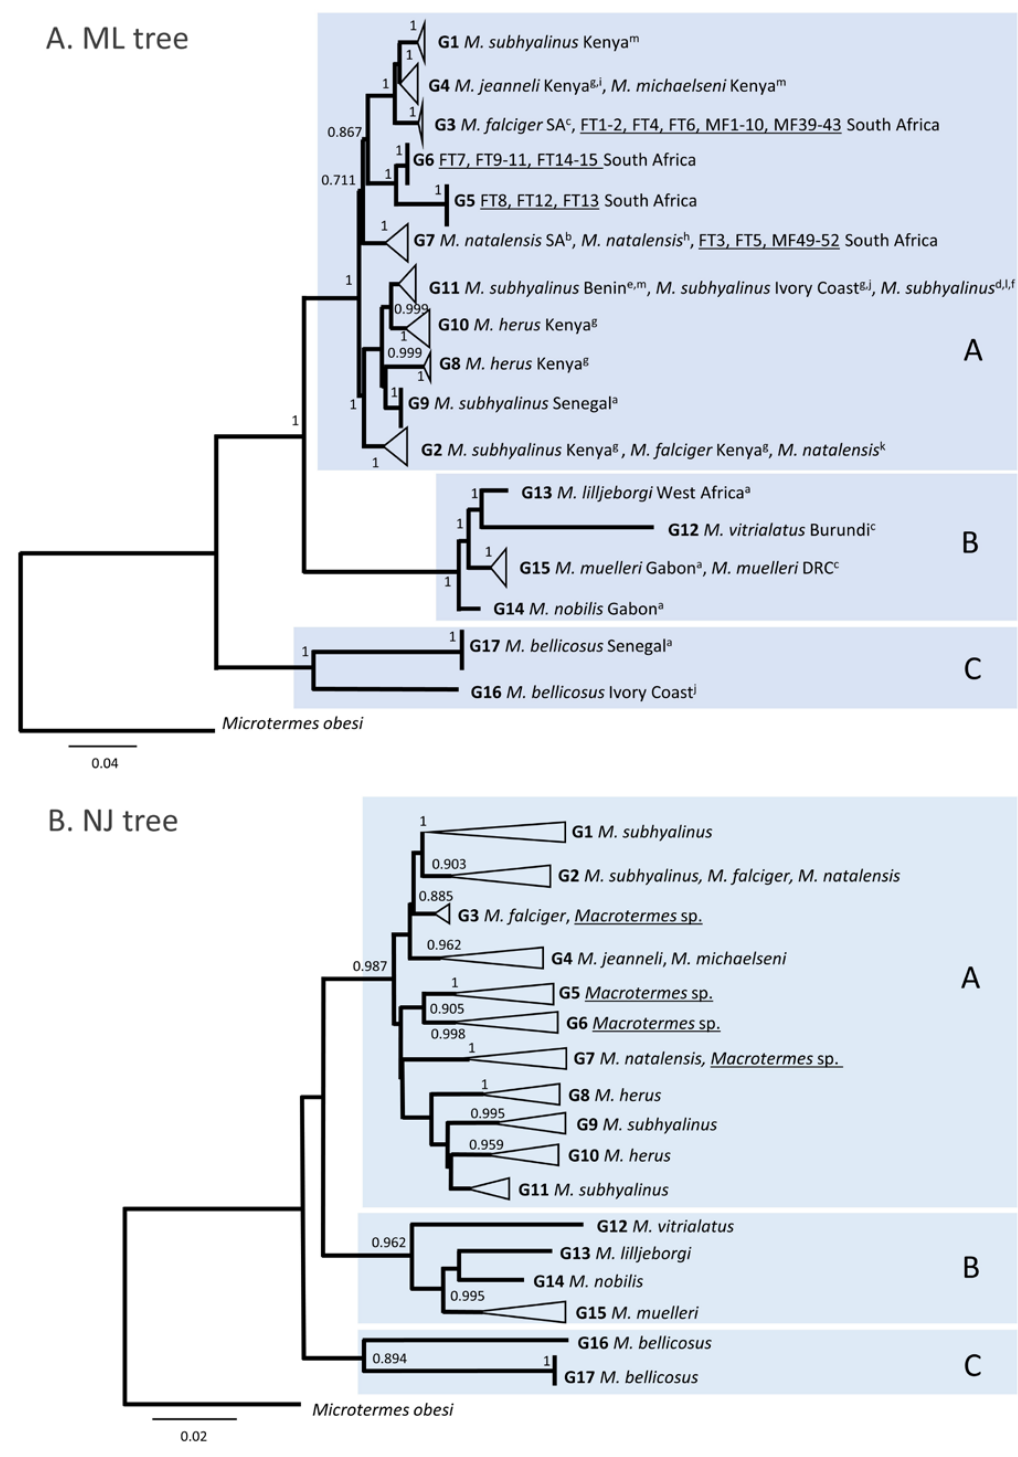
Figure 3. Phylogenetic trees of 228 COI sequences (536 bp) of African Macrotermes . The letters A, B and C on the ML and NJ trees represent the main clades in the phylogeny. G1 to G17 represent the different genetic groups in the dataset (intragroup maximum p-distances <3%). Sequences generated in this study are shown underlined. ( A ) Maximum likelihood tree. a Aanen et al., 2002, b Aanen et al., 2005, c Bourguignon et al., 2017, d Cameron et al., 2012, e Hausberger et al., 2011, f Legendre et al., 2008, g Marten et al., 2009, h Meng et al., 2014, i Nobre et al., 2010, j Nobre et al., 2011, k Pekar et al., 2020, l Svenson et al., 2009, m Vesala et al., 2017. ( B ) Neighbour-joining tree. The main clades and genetic groups are consistent with the topology recovered in the ML